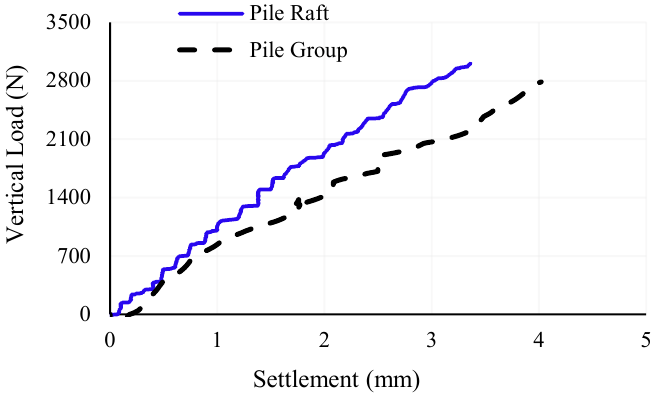
Figure 15. 6-pile group vs. 6-piled raft vertical response.